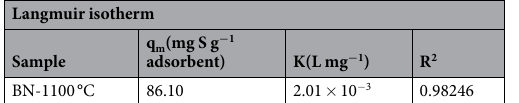
Table 1. Langmuir constants for the adsorption of DBT on porous BN